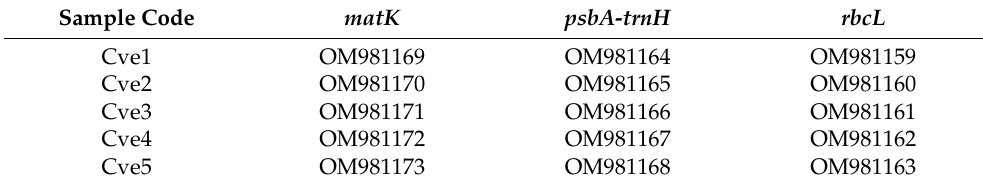
Table 5. GenBank accession numbers of Cinnamomum verum species collected in the